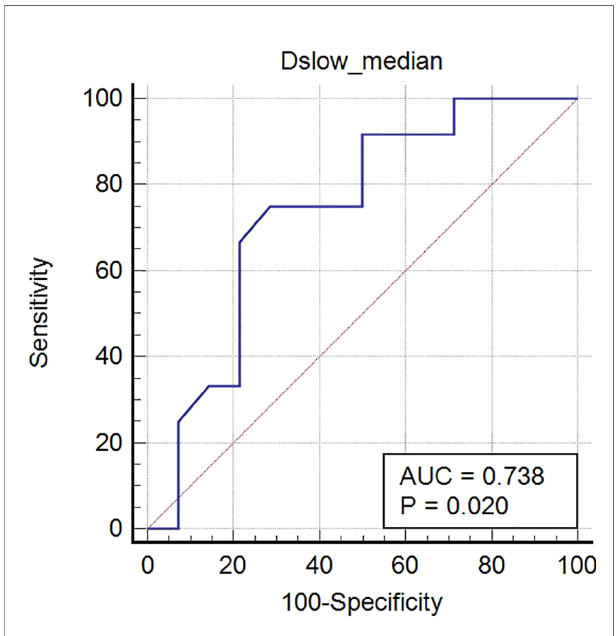
FIGURE 5 | Receiver operating characteristic (ROC) curves of screened independent in fl uencing factors that could distinguish diffuse-type GCs from intestinal/mixed-type GCs. FP P95th had the largest AUC of 0.896. Comparisons among the four metrics determined that these values were signi fi cantly different (P <0.05), although no differences (P >0.05) were detected when paired comparisons among the ADC median , Dslow median , and Dslow entropy values were performed.